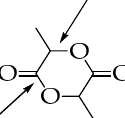
Figure 3. Different opening positions of the lactide ring.